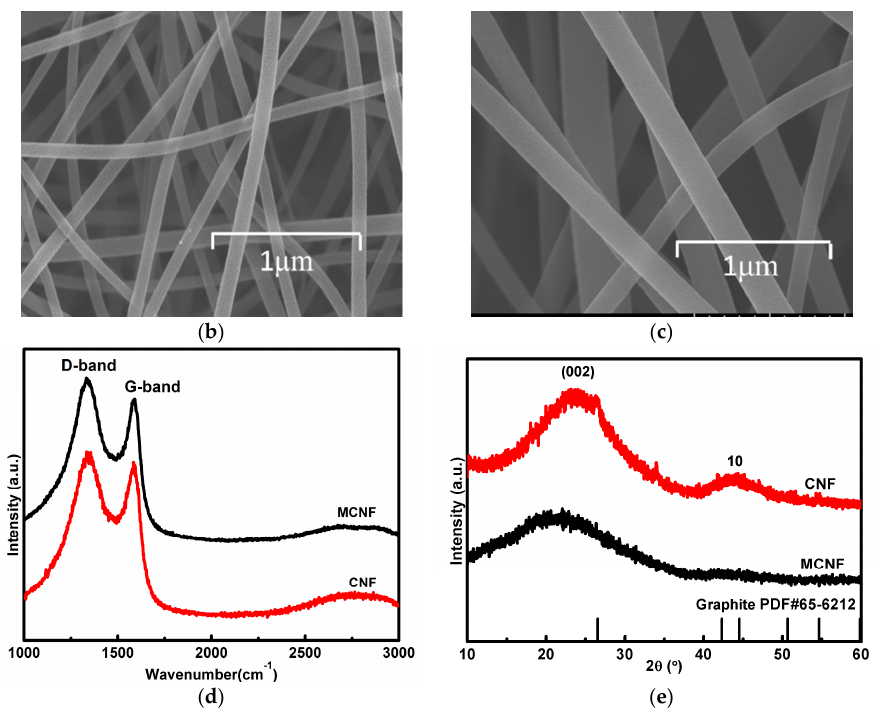
Figure 2. Digital image of N-rich carbon nanofibers (MCNF) ( a ) and SEM images of MCNF ( b ) and carbon nanofibers (CNF) ( c ); Raman spectrum of MCNF and CNF ( d ); X-Ray diffraction pattern of MCNF and CNF ( e ).